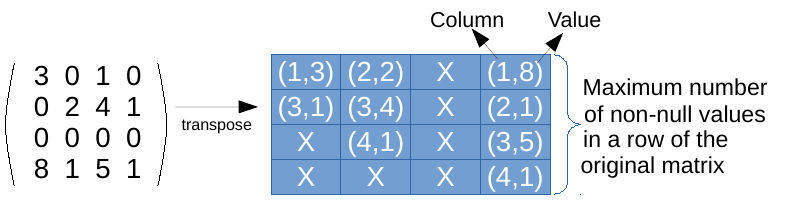
Figure 2. ELL format example. Note that it represents the transpose of the original matrix to increase the coalesced access in GPU devices. It includes pairs of column and value for every row. The compressed matrix has a number of columns equals to the number of original rows, and a number of rows equals to the maximum amount of non-null values in an original row.